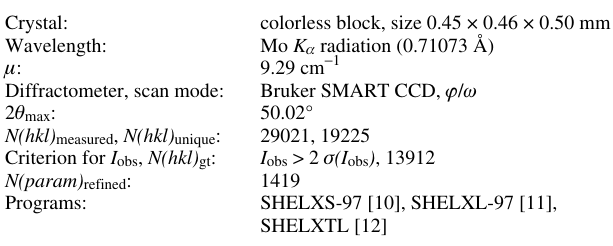
Table 1. Data collection and